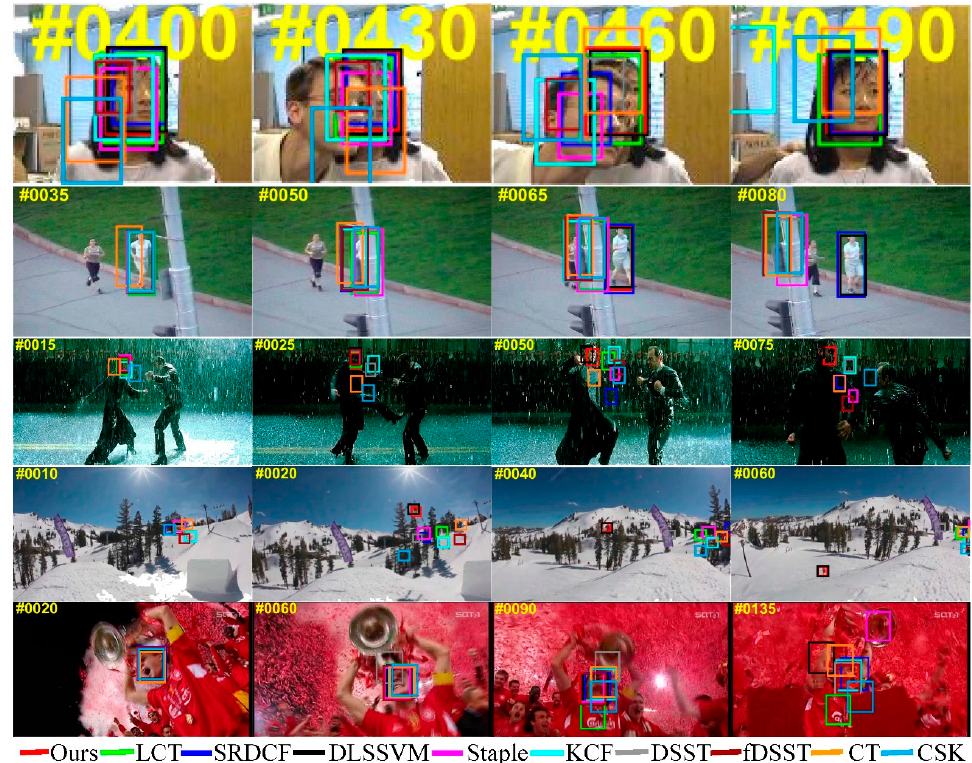
Figure 7. Tracking results on the five sequences of OTB2013 from 10